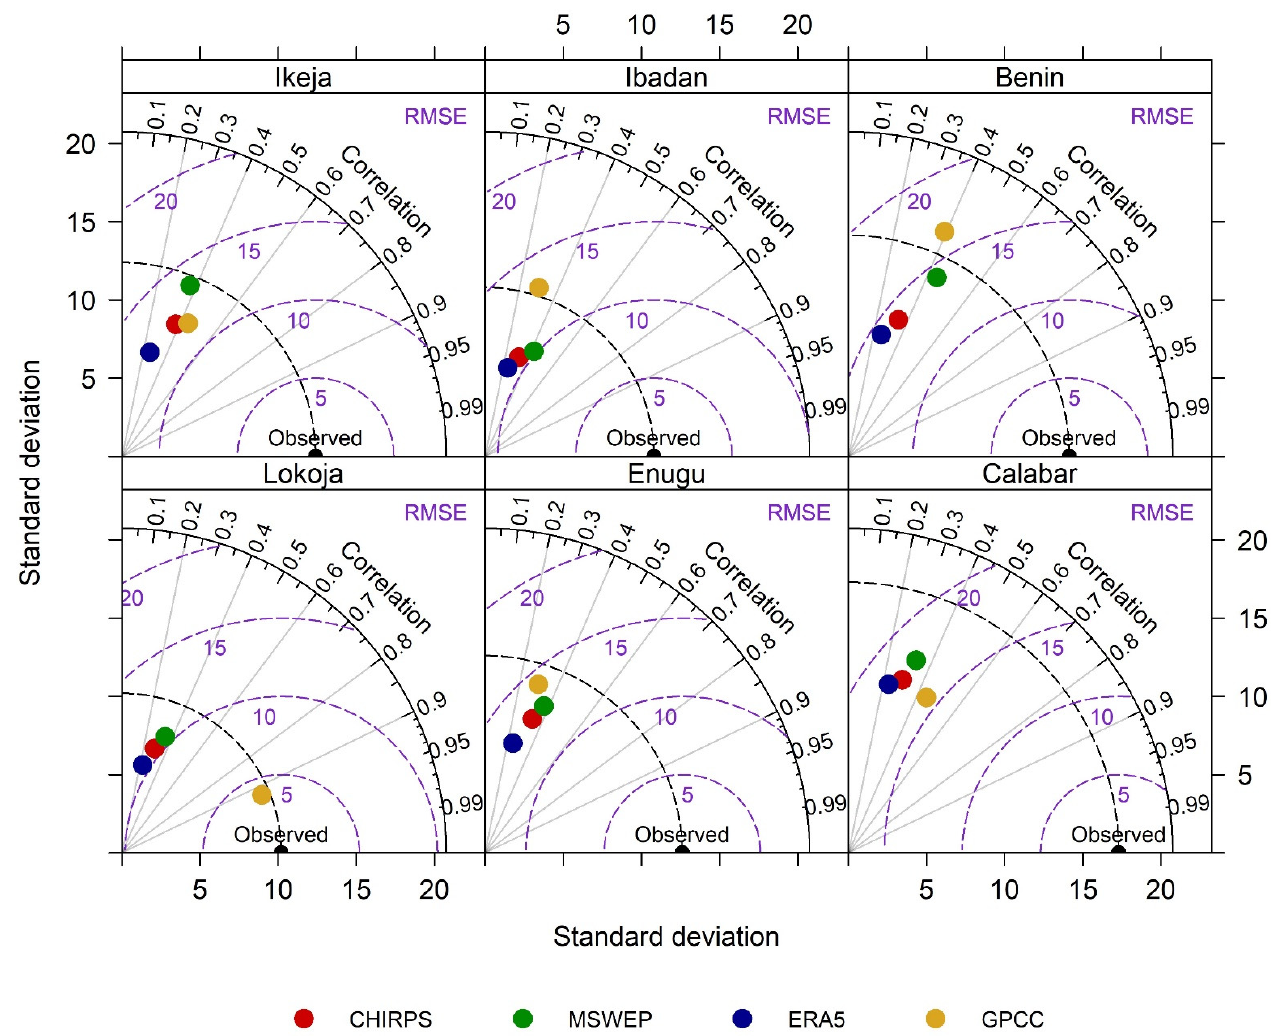
Figure 5. Taylor Diagram of Synoptic Stations within Guinea coast region. Correlation and RMSE values for some selected synoptic stations within each of the three climatic zones, as presented in Figure 3 (Sahel), Figure 4 (Savannah) and Figure 5 (Guinea), show varying results without any particular order at daily temporal resolution.